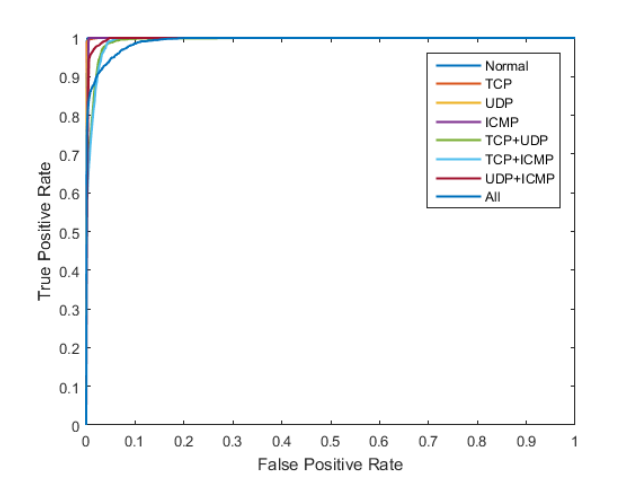
Figure 7. ROC curve for 8-class classification